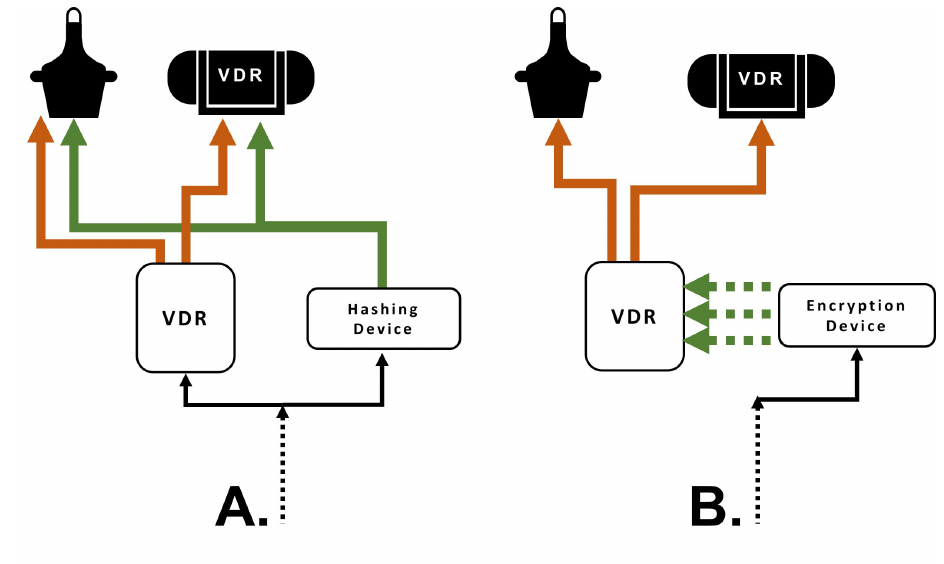
Figure 4. Cryptographic methods for VDR security. ( A ) Storage of a hash of sensor input for verification, ( B ) Encryption of sensor data prior to VDR